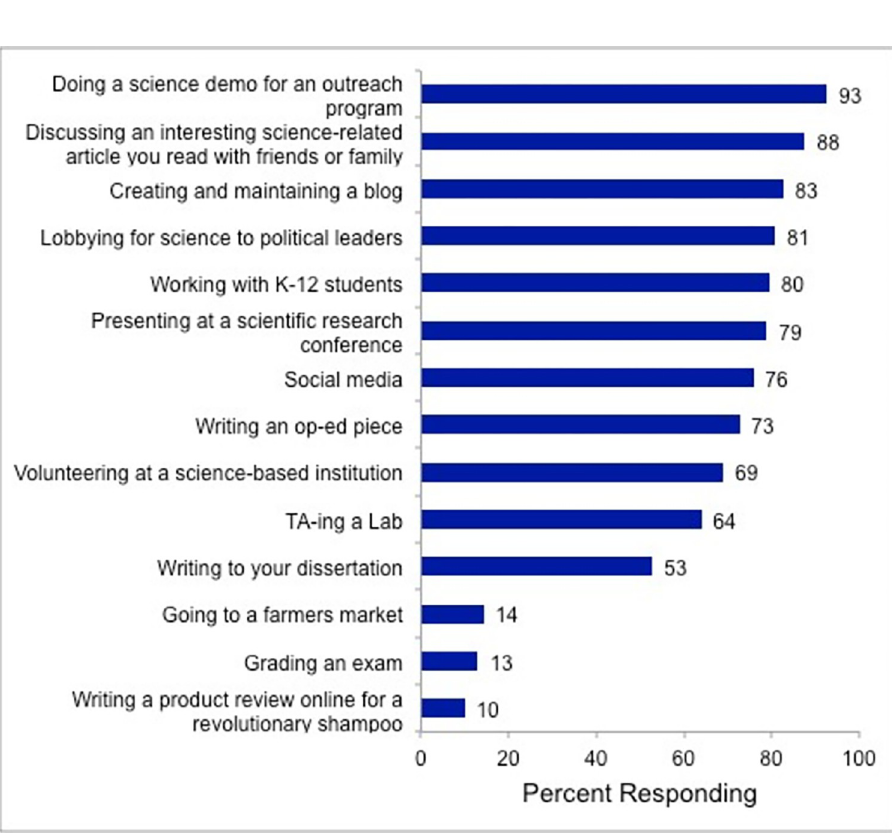
Fig 5. What do participants consider to be science communication? participants were asked “which of the following do you consider to fall within the category of science communication?” and directed to select all that apply. Data is shown as percent